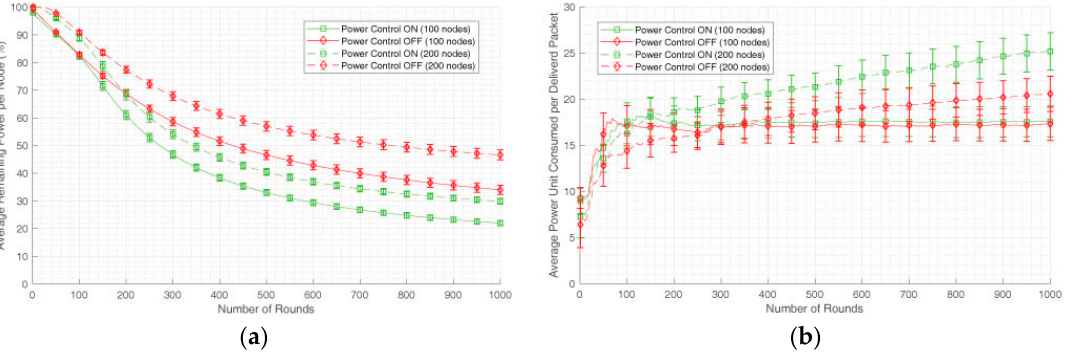
Figure 4. Network performance in terms of ( a ) average remaining power per node and ( b ) average power consumed per delivered packet.